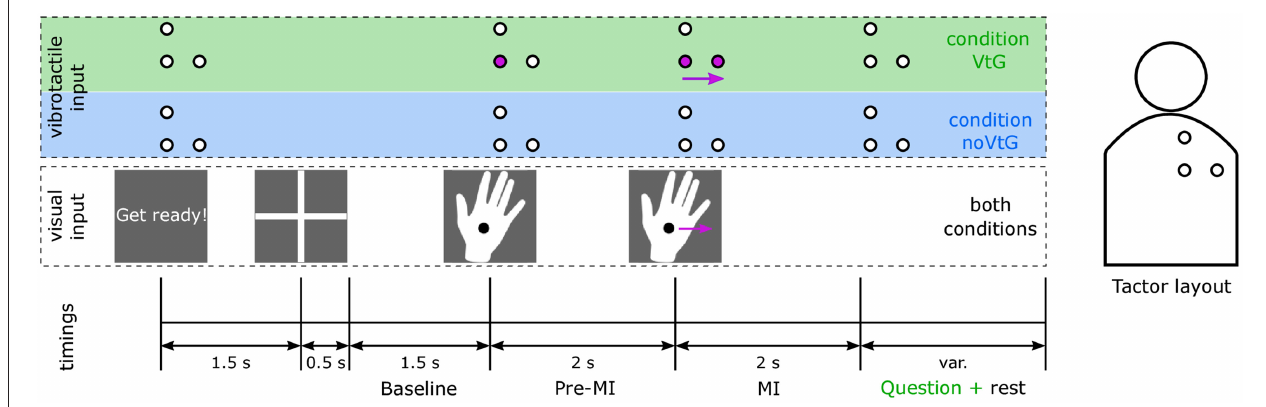
FIGURE 1 | Trial structure according to the experimental paradigm, and tactor layout. The time intervals are indicated at the bottom. The middle row illustrates the visual cues, which were identical in both conditions, and the top row (highlighted in green and blue to identify the conditions VtG and noVtG, respectively) the vibrotactile guidance, respectively. The circles represent the tactors, as illustrated in the sketch of the tactor layout on the right. Active tactors are marked in purple, and idle tactors are presented in white. The purple arrows represent movement in both representations (visual and vibrotactile), in the presented example a movement to the right. The participant was visually alerted to the beginning of each trial, 1.5 s before the appearance of the fixation cross. The fixation cross was on screen for 2 s, the latter 1.5 s of which were later used as a baseline period. During this period, participants were instructed to fixate their gaze on the fixation cross, and relax. Afterwards, the visual cue, a right hand with a fixation point, appeared on the monitor. It remained stationary for the pre-MI period of 2 s, and then moved either to the right or up at a constant speed. Participants were instructed to perform the MI in accordance with the movement of the cue. In condition VtG, participants were subsequently asked to judge whether the vibrotactile guidance was congruent to the visual guidance in this trial, and to respond with a key press.